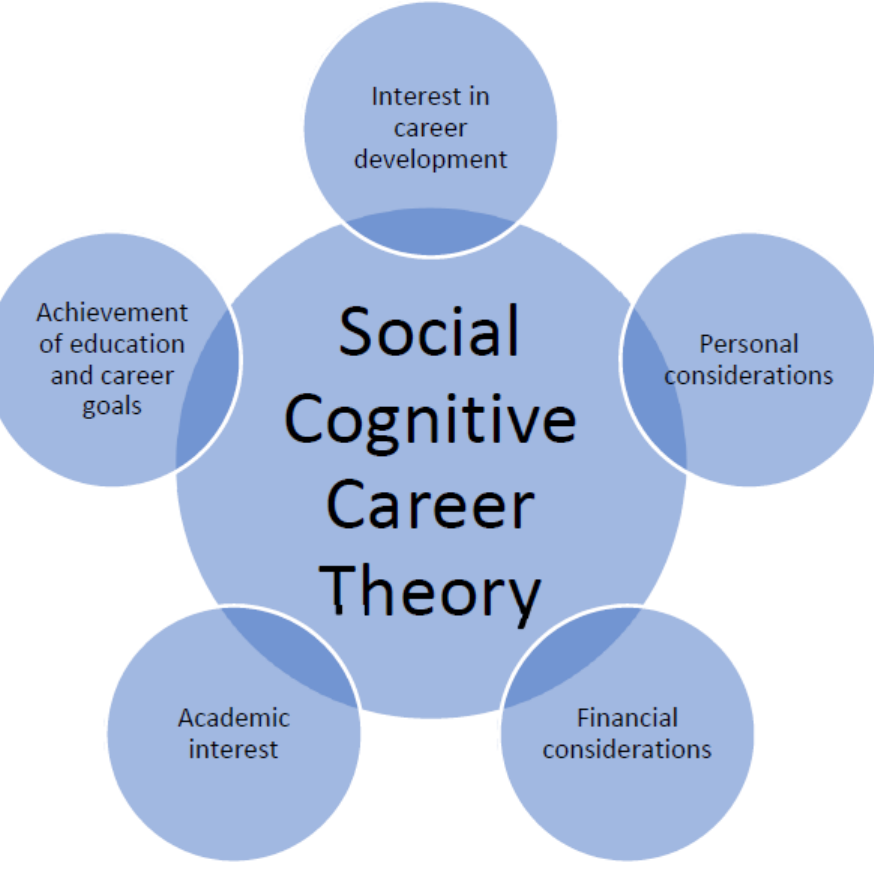
Figure 1. Social cognitive career